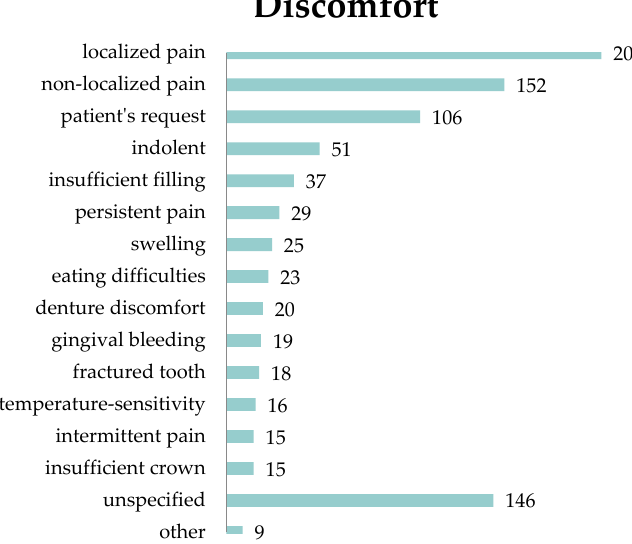
Figure 2. Absolute frequency of dental discomfort. Pain is the most common complaint.